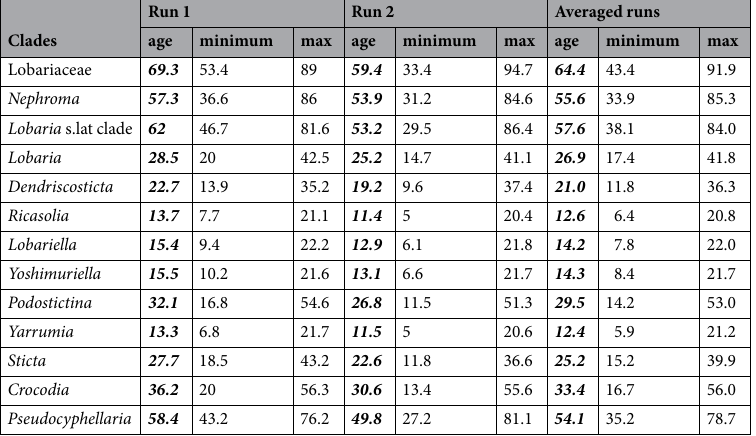
Table 4. Node ages estimated in MCMCTree with error ranges in millions of